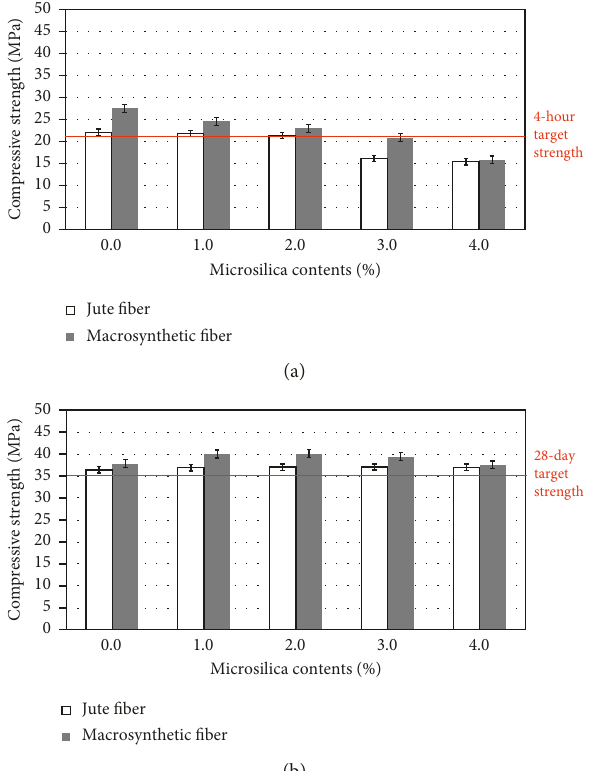
Figure 5: Compressive strength of LMFRCRSC. (a) 4-hour curing. (b) 28-day curing.